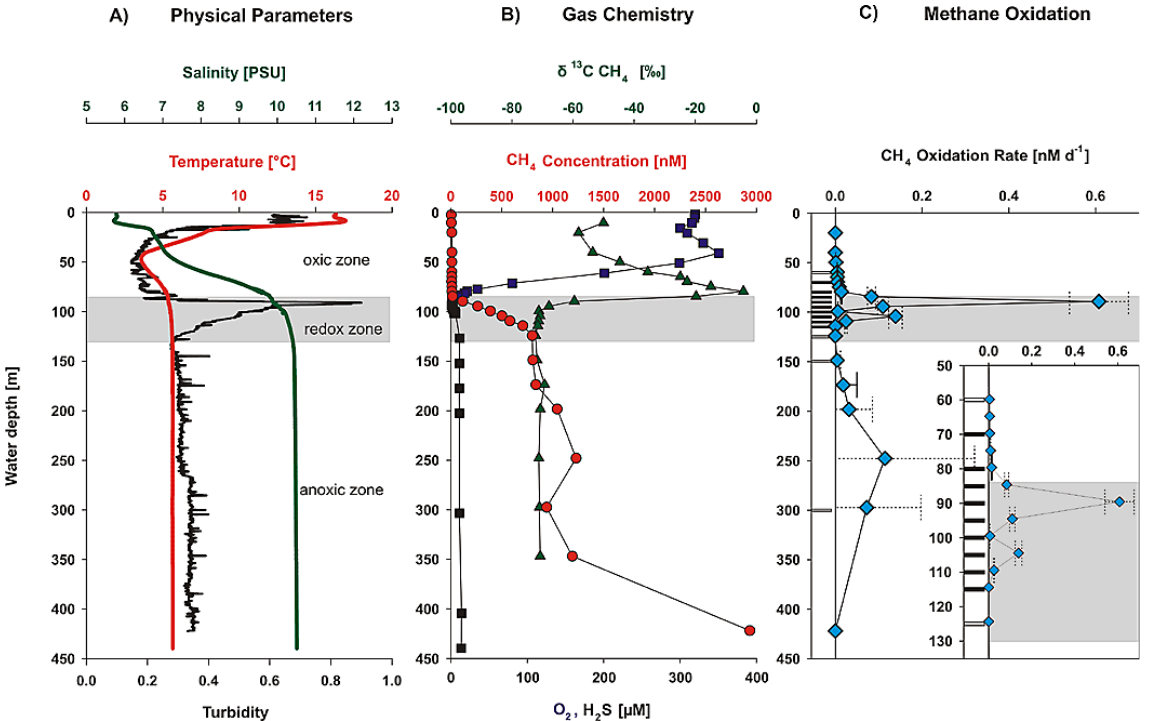
Fig. 3. Landsort Deep. (A) Vertical profiles of salinity (green), temperature (red) and turbidity (black); (B) oxygen (blue squares) and hydrogen sulfide (black squares), methane (red circles) and δ 13 C values of methane (green triangles); (C) methane oxidation rates (light-blue diamonds) and sampling depths of pmoA gene expression analysis (black bars denote the occurrence and white bars the absence of active type I methanotrophs). To obtain the standard deviation ( s ) for methane oxidation rates, triplicates were taken in three water depths (70, 80, 175m). The solid error bars indicate the standard deviation from these triplicates, whereas the dashed error bars show the standard deviation calculated from these triplicates for the single water samples. The redox zone is indicated by the gray-shaded area. The insert in (C) illustrates the depth interval of the redox zone in higher vertical resolution. Table 1. Result